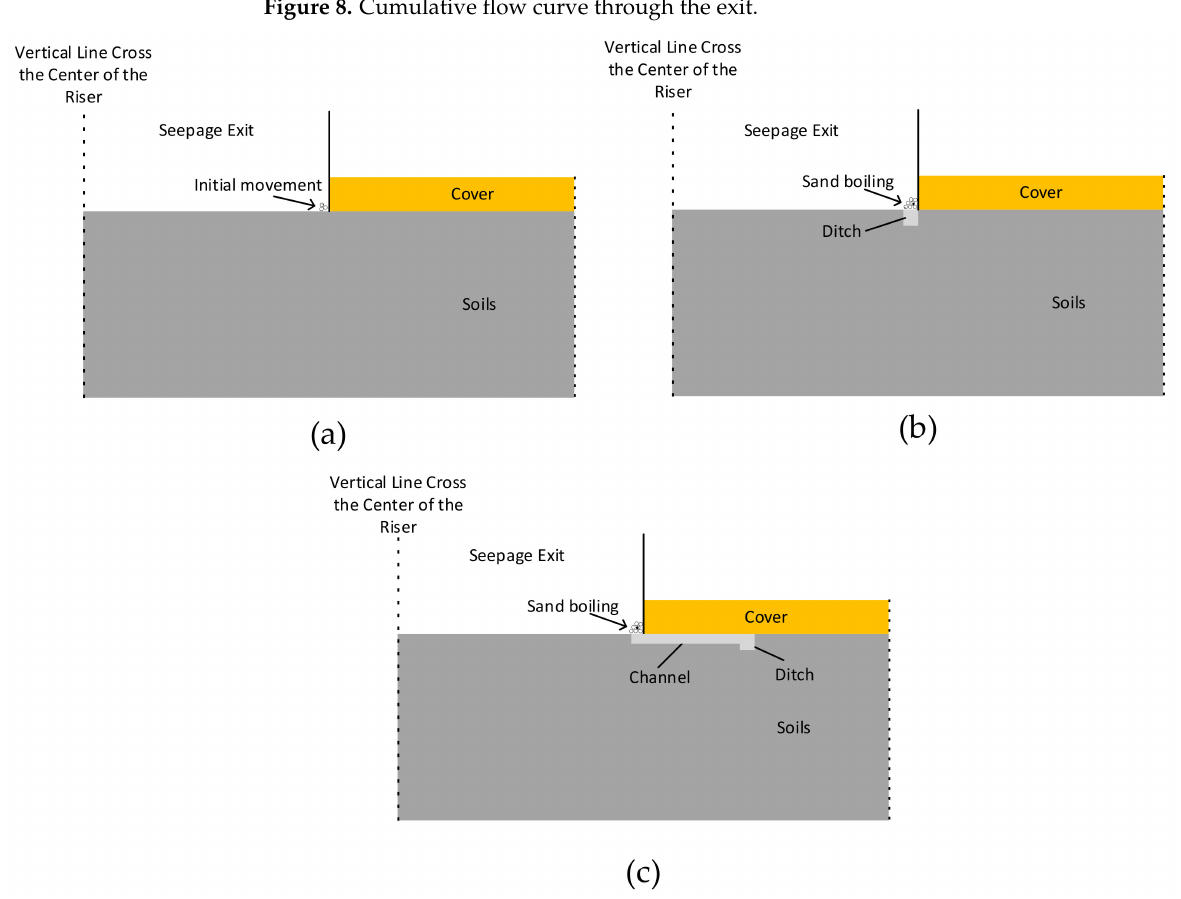
Figure 9. Schematic illustration of erosion development of BEP: ( a ) initial movement; ( b ) sand boiling; and ( c ) channel development (the location of the figure being referred to is at the very top of the sample with riser and cover, see Figure